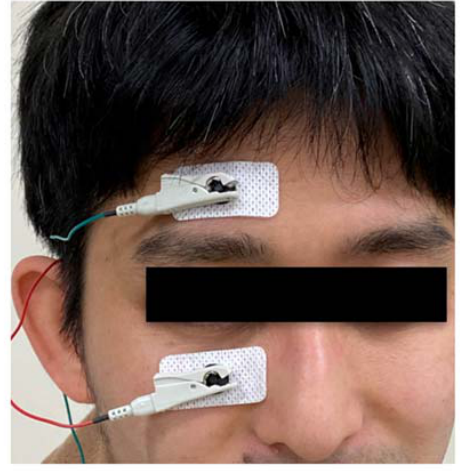
Figure 1. The location of the electrical pads.